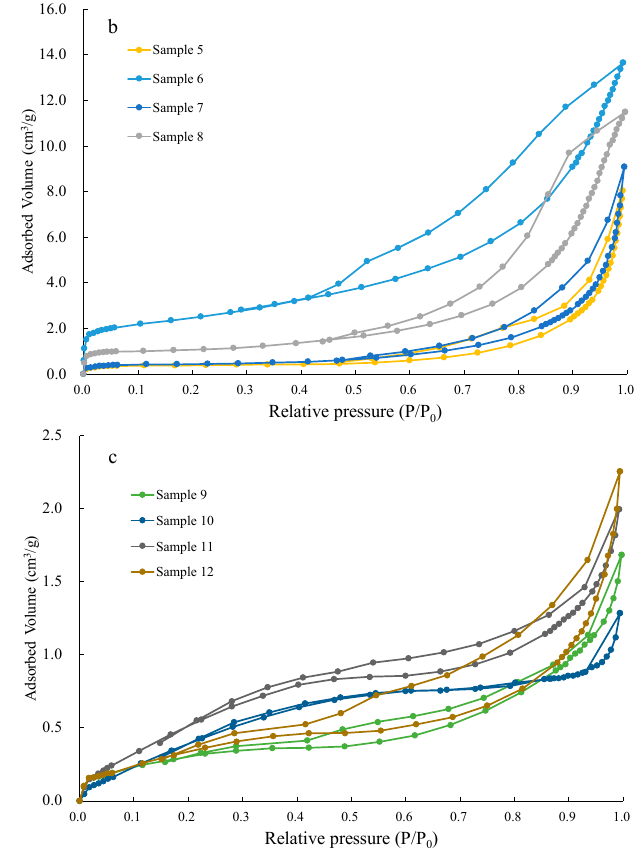
Figure 3. The nitrogen adsorption-desorption curves of the Bakken samples. ( a ) Upper Bakken; ( b ) Middle Bakken; ( c ) Lower Bakken.